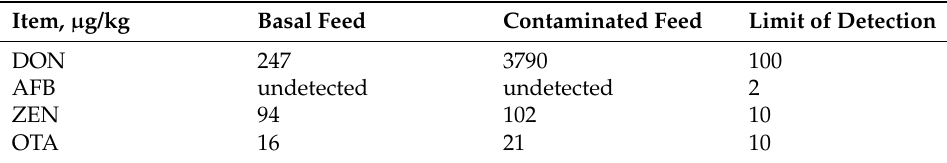
Table 1. The levels of main mycotoxins in